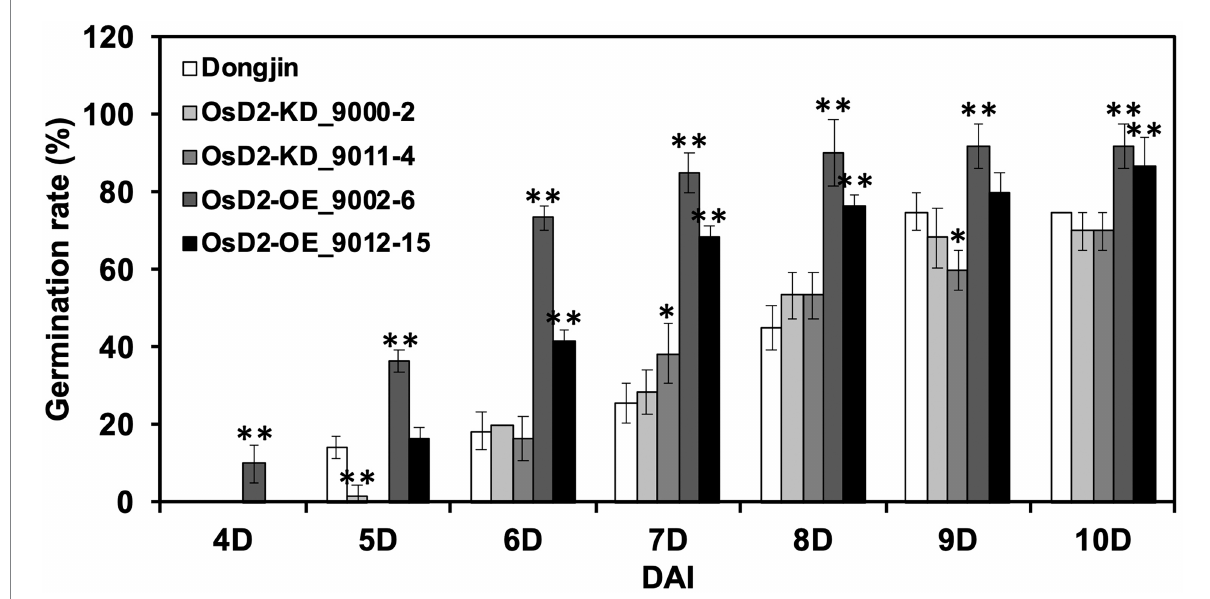
FIGURE 4 Low-temperature germinability of OsD2 T-DNA insertion lines and Dongjin (DJ). Seeds of OsD2 -KD (9000-2, 9011-4), OsD2 -OE (9002-6, 9012- 15), and Dongjin were incubated at 13 ° C for 10 days. Data are presented by mean ± SD ( n = 3). * and ** indicate significant difference between each T-DNA insertion line and Dongjin at p < 0.05 and p < 0.01, respectively, based on the Student’s t